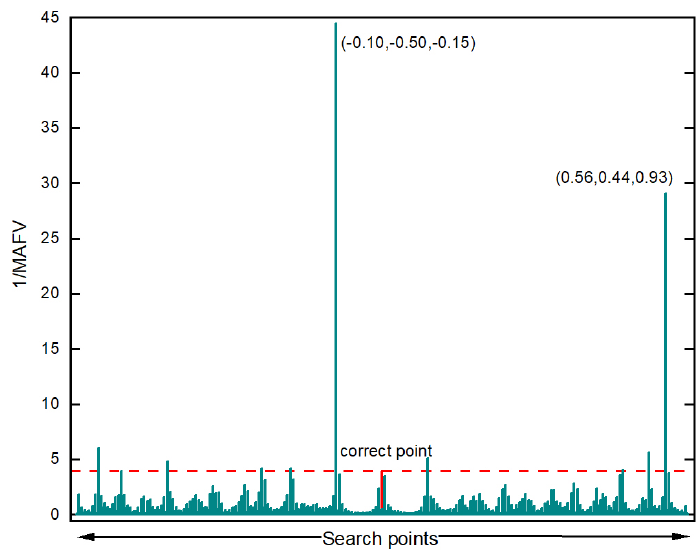
Figure 7. 1/MAFV result in x , y , z domain: ± 1 m around the referenced value.